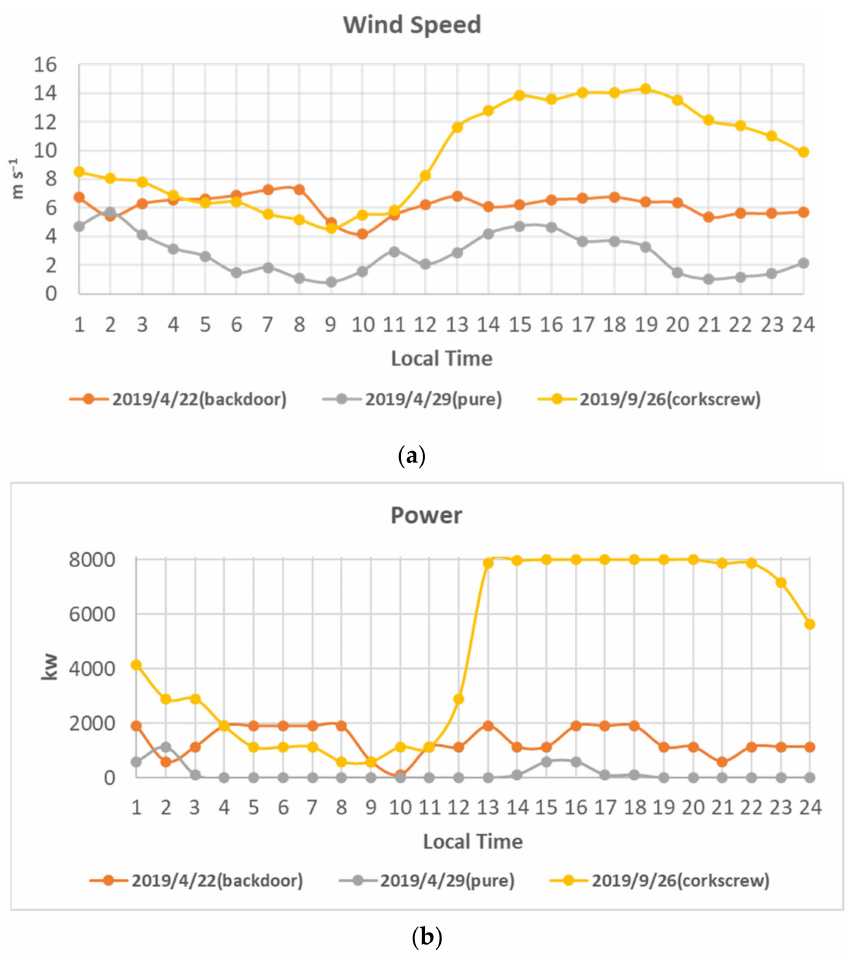
Figure 20. ( a ) The typical daily wind speed curve of each sea breeze type. ( b ) The typical daily power production curve of each sea breeze